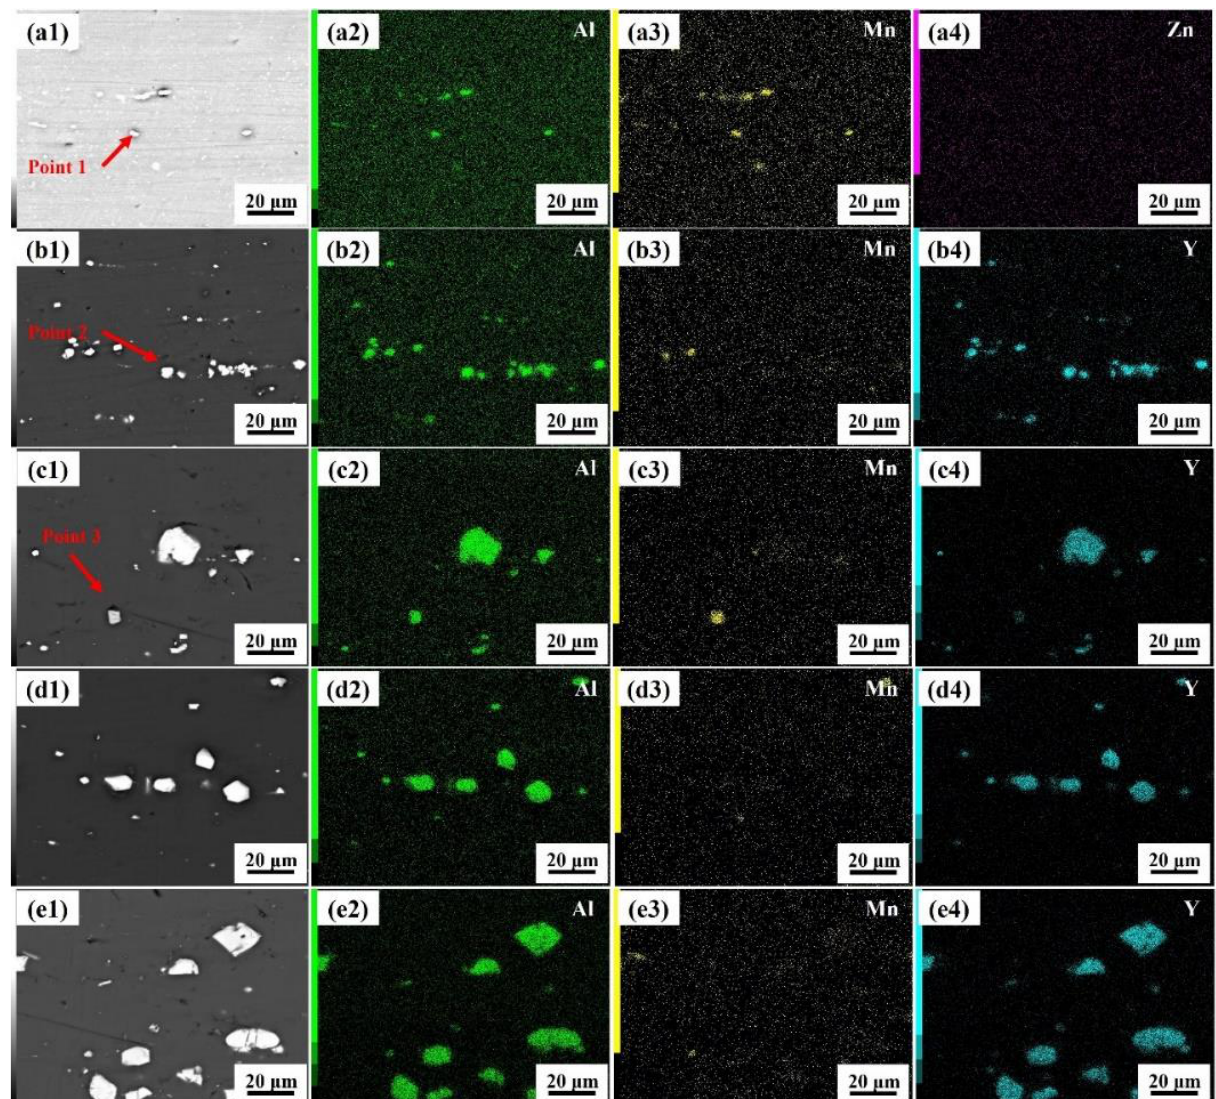
Figure 3. SEM images and EDS images of the rolled sheets with different Y contents: ( a ) AZY0; ( b ) AZY1; ( c ) AZY2; ( d ) AZY3; and ( e ) AZY4.